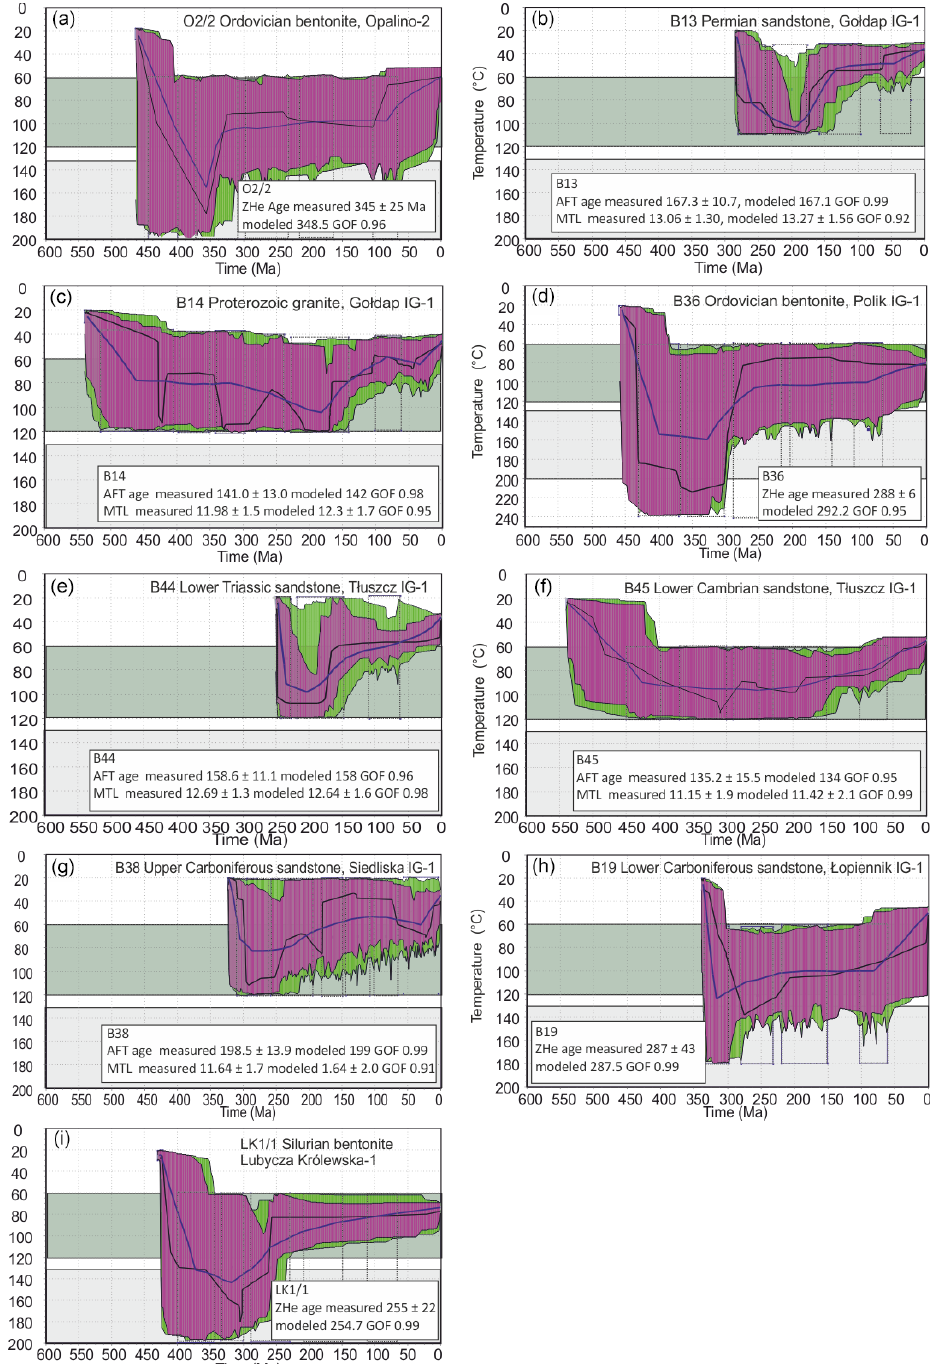
Figure 13. Thermal modelling results from HeFTy software (Ketcham, 2005). The light green range corresponds to the envelope of thermal paths with acceptable fit (GOF > 0.05); the magenta range shows the envelope for thermal paths with good fit (GOF > 0.5). The bold dark blue curve shows weighted mean path, whereas thin black line is the best-fit curve. Black rectangles correspond to constrained boxes. Grey rectangles show apatite partial annealing zone (60–120 ◦ C) and zircon partial retention zone (130–200 ◦ C). Further explanations are in the